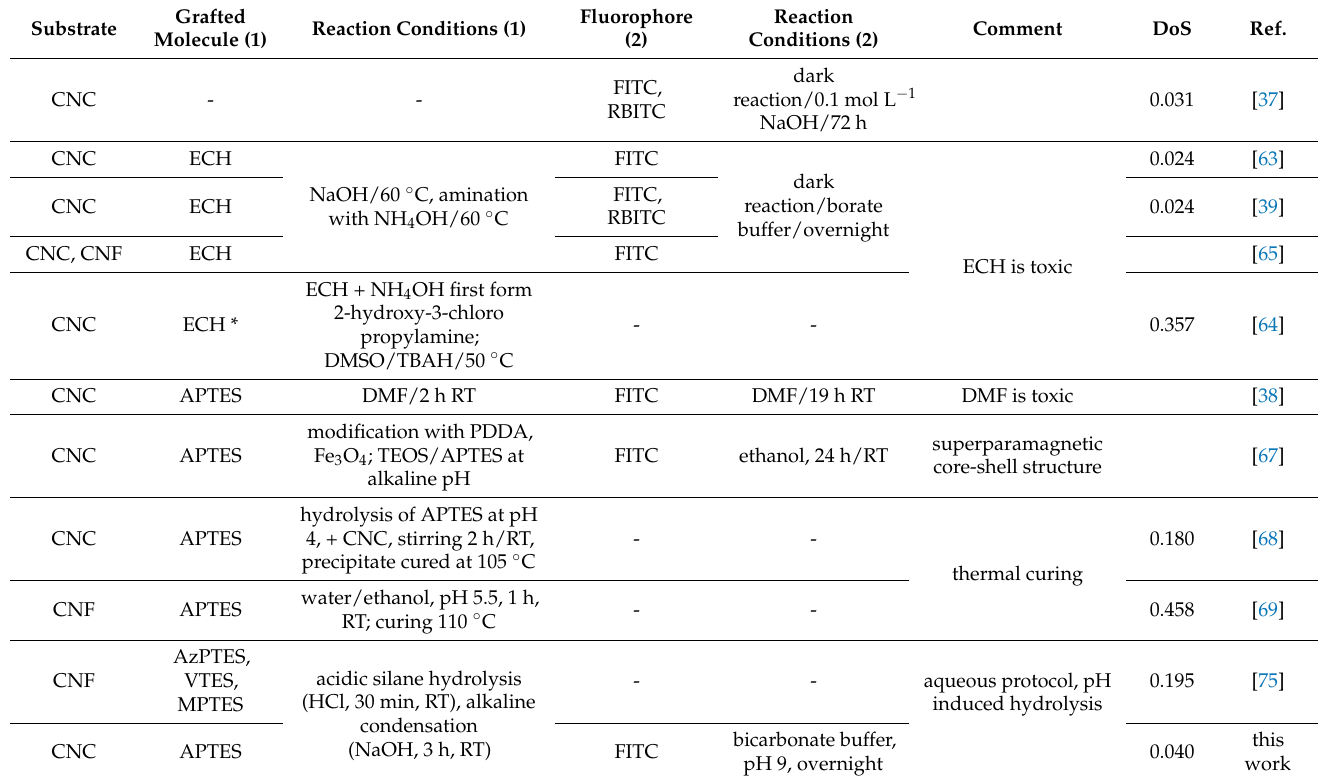
Table 1. Overview of similar functionalization strategies for FITC on carbohydrate substrates; (1) and (2) are the respective synthesis